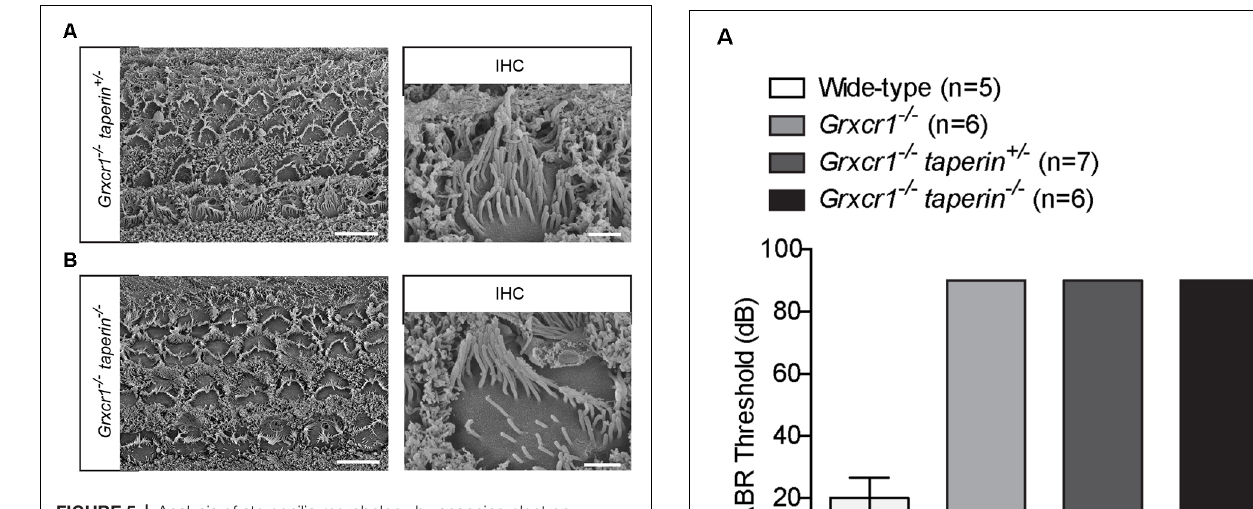
FIGURE 5 | Analysis of stereocilia morphology by scanning electron microscopy. (A,B) Whole mounts from the middle region of the cochlea from Grxcr1 − / − taperin + / − (A) and Grxcr1 − / − taperin − / − (B) mice at the age of P7 were analyzed by scanning electron microscopy. Note, stereocilia in Grxcr1 − / − , Grxcr1 − / − taperin + / − , and Grxcr1 − / − taperin − / − mice were extremely thin and disorganized. Scale bars: left, 5 µ m; right, 1 µ m.